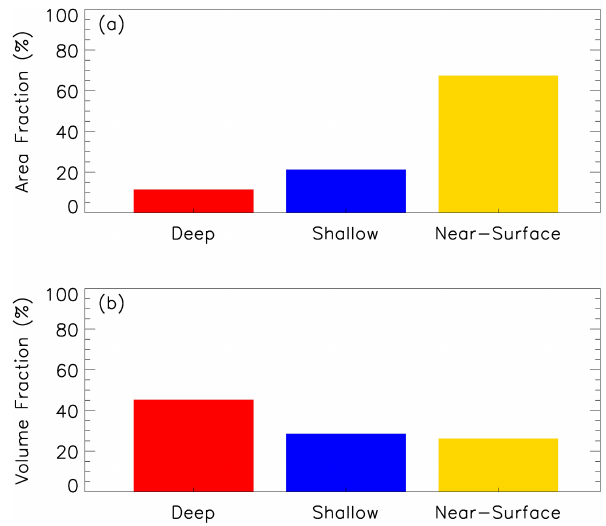
Figure 3. (a) Area and (b) volume fractions of the three types of snow clouds observed during the 2017–2018 winter season.